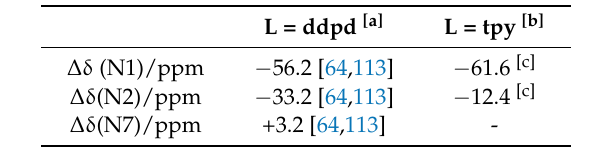
Table 6. Coordination shift δ = δ (complex) − δ (ligand) of 15 N resonances of diamagnetic [Fe(L) 2 ] 2+ complexes in CD 3 CN (L = ddpd,